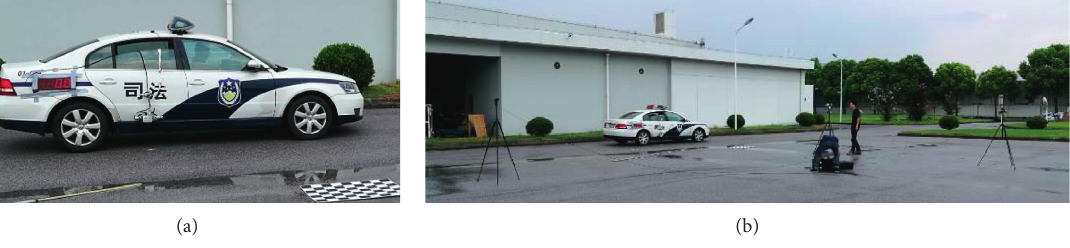
Figure 3: Test vehicle, equipment, and scene.